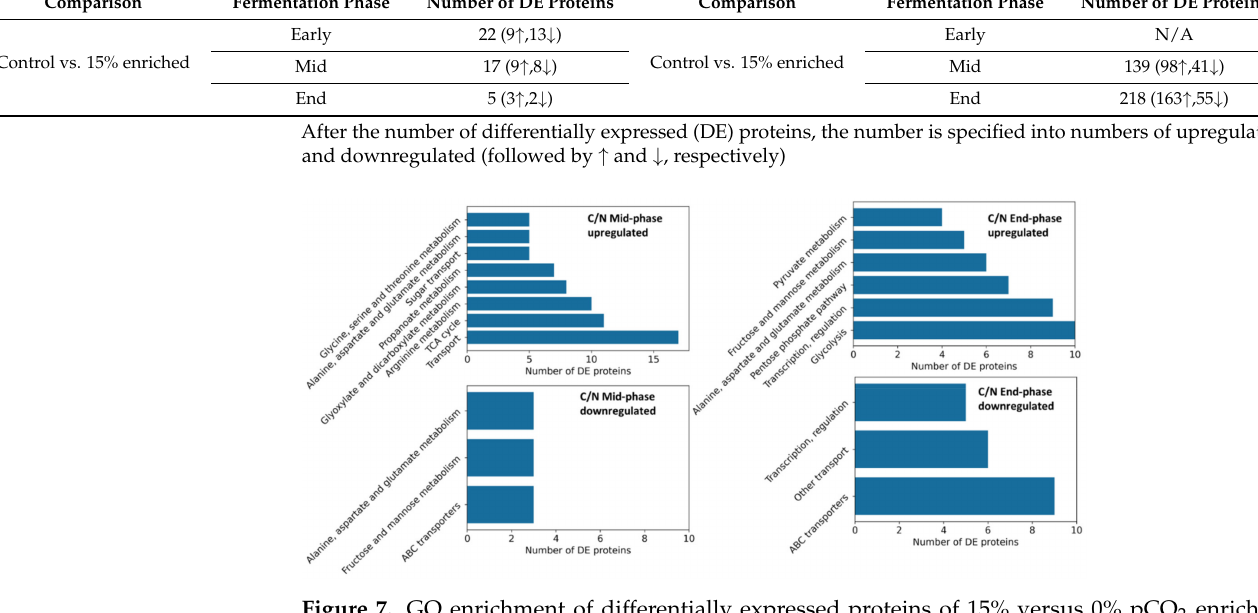
Figure 7. GO enrichment of differentially expressed proteins of 15% versus 0% pCO 2 enriched cultures under C/N-limited